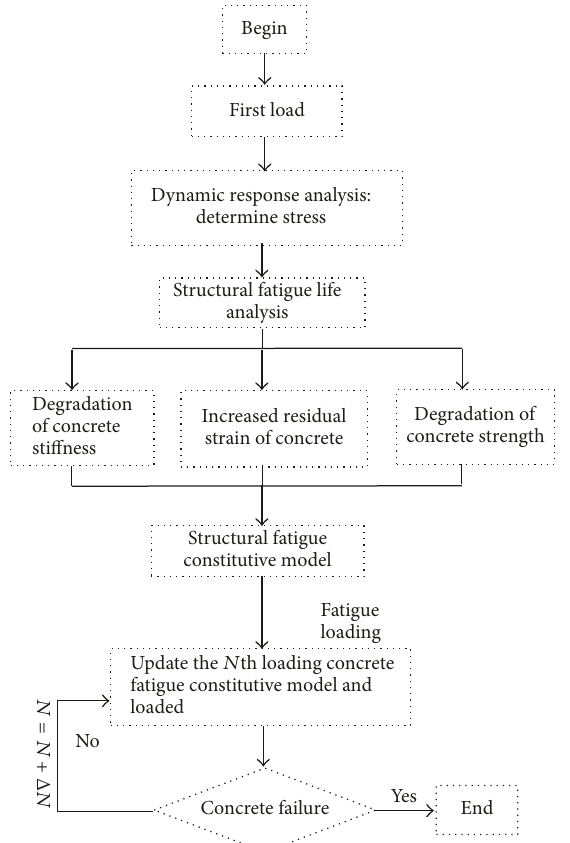
Figure 2: Flowchart of structural damage analysis.